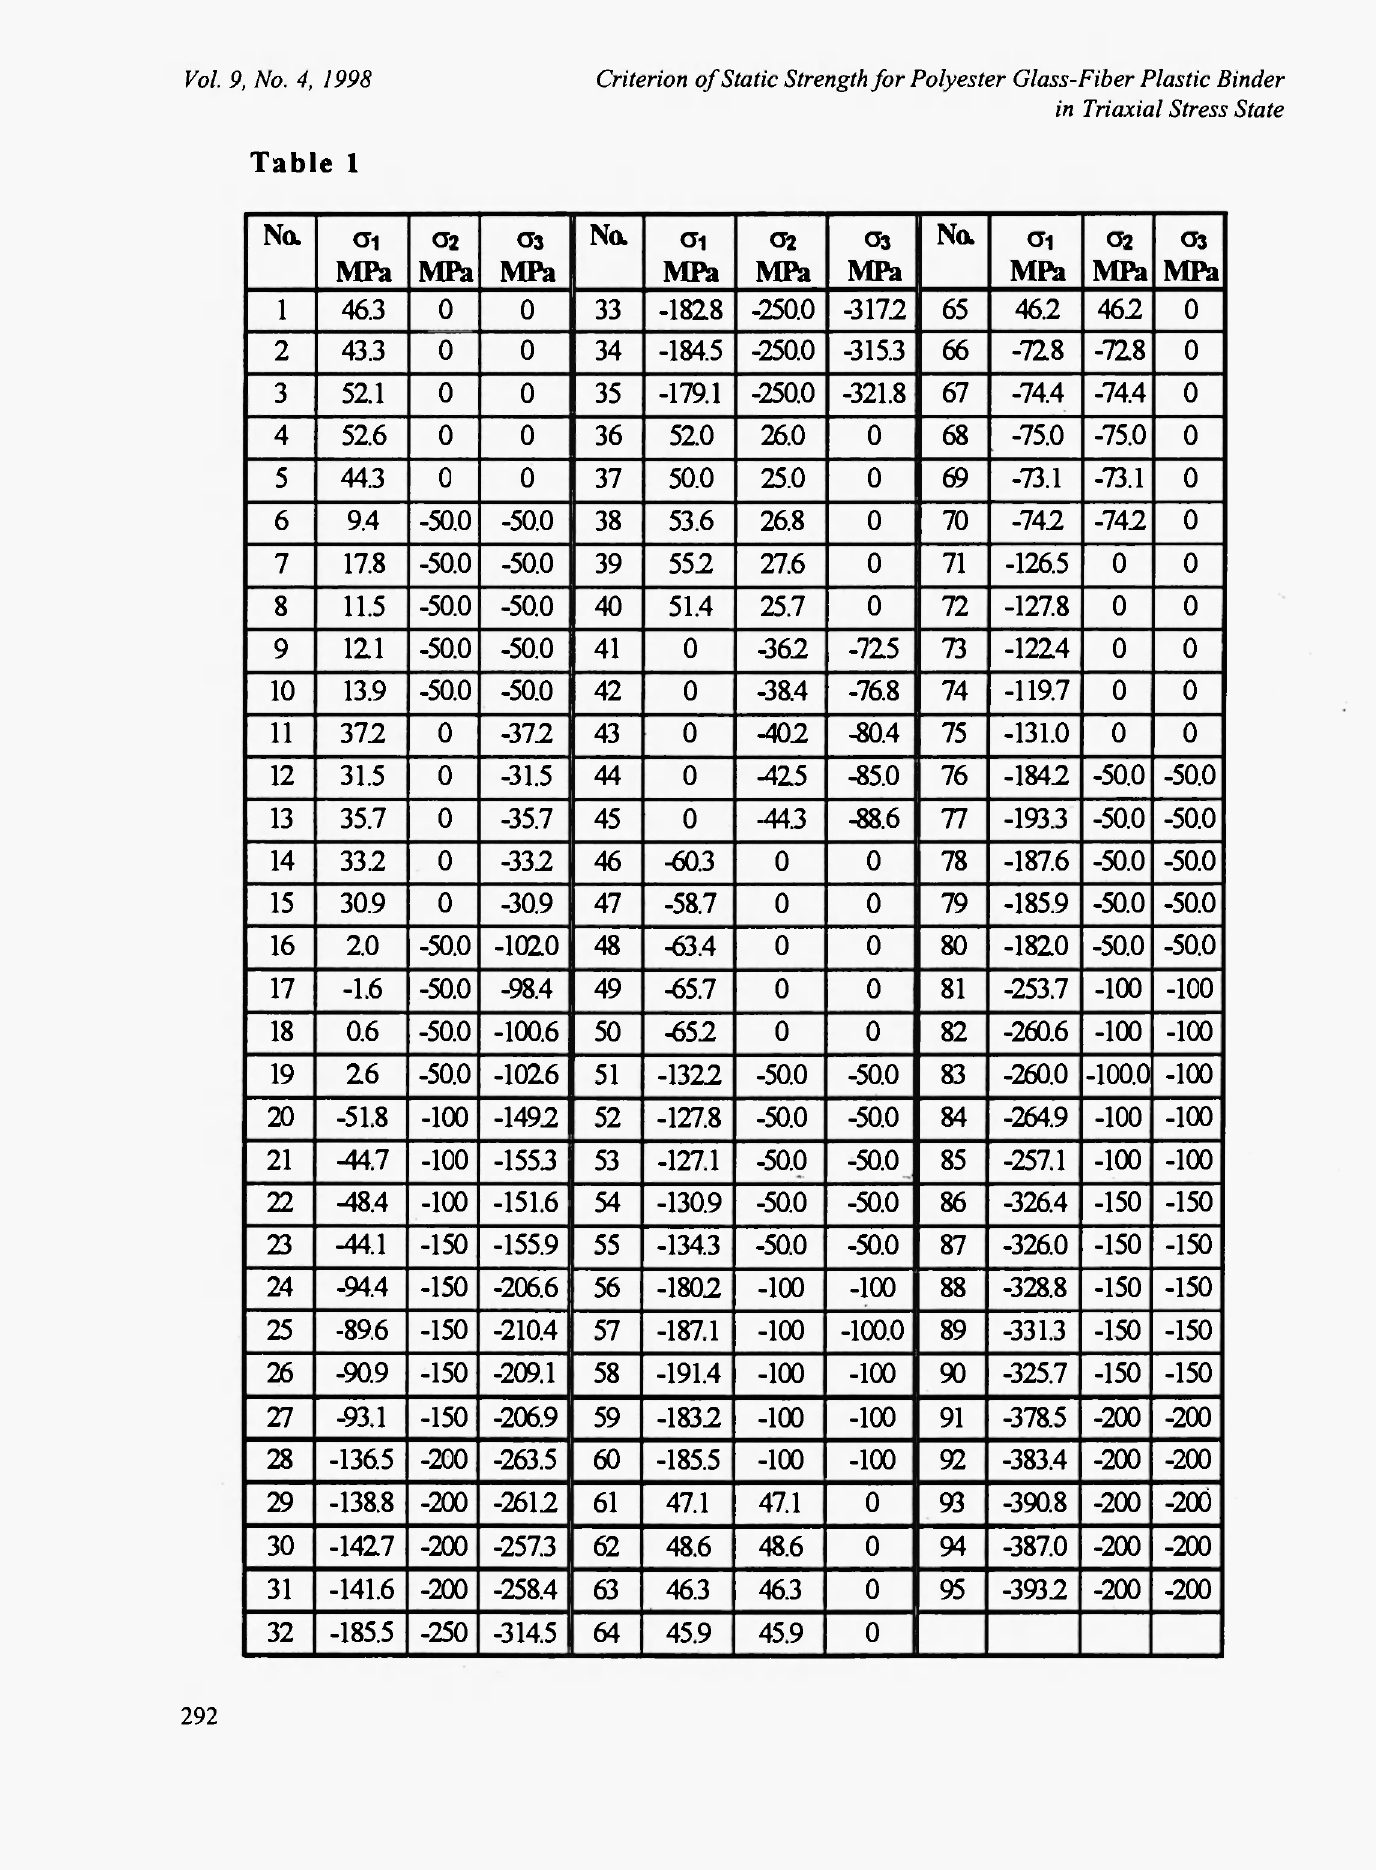
Criterion of Static Strength for Polyester Glass-Fiber Plastic Binder